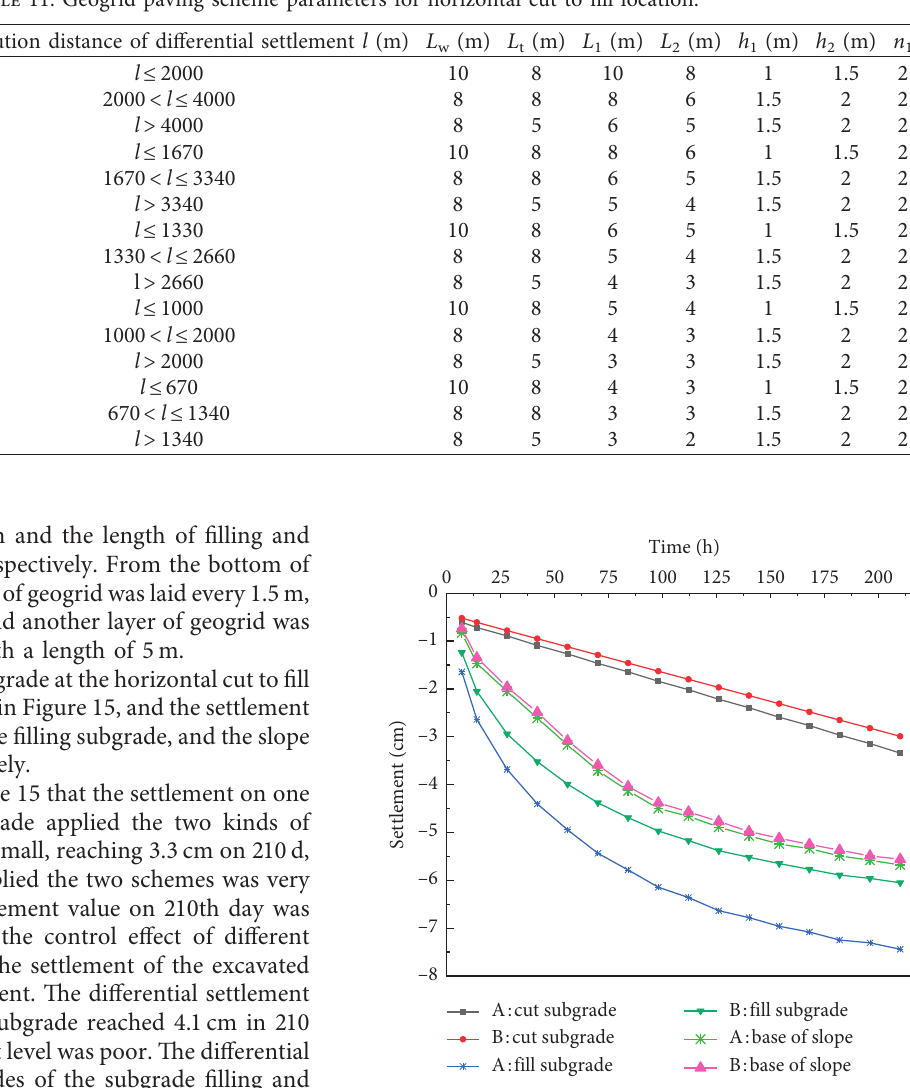
Table 11: Geogrid paving scheme parameters for horizontal cut to fill location.